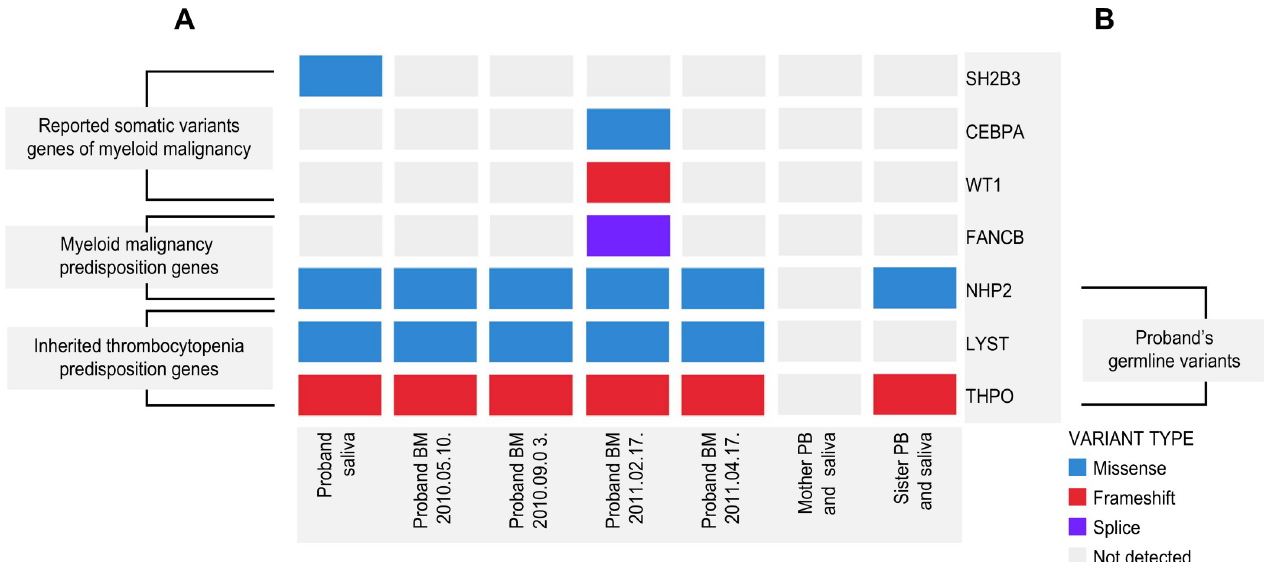
Fig 5. Heatmap showing gene variants in the proband (patient 1) family. (A). Of all variants filtered out by targeted multigene sequencing performed on the proband’s family, only myeloid malignancy predisposition genes, inherited thrombocytopenia predisposition genes, and somatic variants of myeloid malignancy-related genes are represented. Inherited thrombocytopenia predisposition genes were identified based on guidelines in Bury et al. [1]. Myeloid malignancy predisposition genes identified were based on the WHO criteria and NCCN guidelines. The somatic variant was identified based on the NCCN guidelines and reported in the COSMIC database. (B). The variants of THPO , LYST , and NHP2 genes were observed in the proband and sister specimens and classified into germline variants of the proband. Because of the absence of the proband’s father’s information, the variants of FANCB , WT1 , CEBPA , and SH2B3 could not be classified as somatic or germline variants. BM, bone marrow; PB, peripheral blood; WHO criteria, World Health Organization classification of tumors of hematopoietic and lymphoid tissues; NCCN, The National Comprehensive Cancer Network; COSMIC, Catalog Of Somatic Mutations in Cancer.